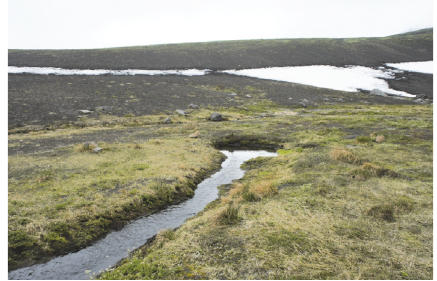
Figure 28: Cold spring (C5) on a Northern slope of Koryaksky Volcano, August 2013. Photo by V. Lavrushin.